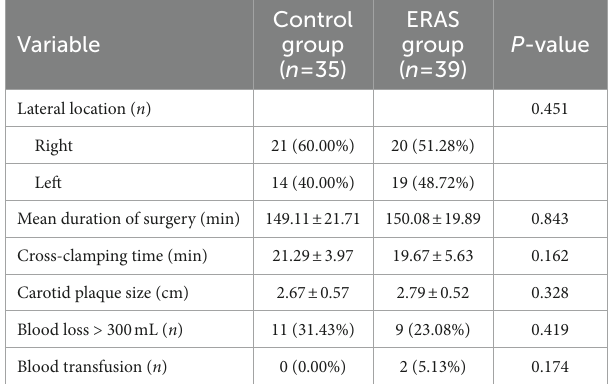
TABLE 1 Sociodemographic and clinical features [Mean + SD, n (%)]. TABLE 2 Surgery characteristics [Mean + SD, n